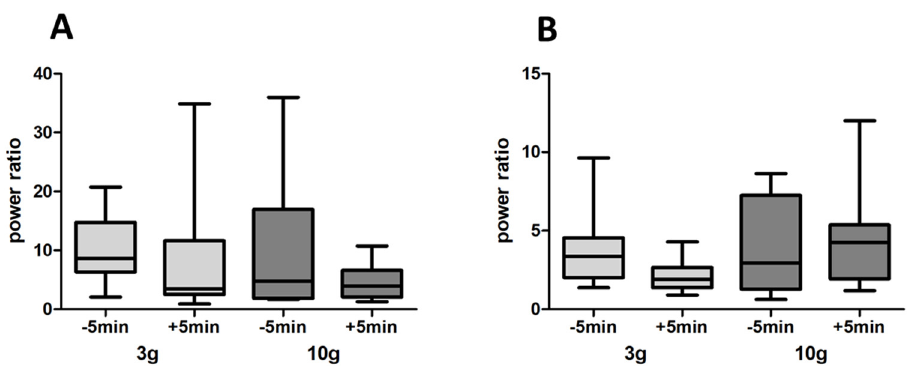
Figure 9. ( A ) . Simultaneous i.v. administration of the D1 agonist A68930 and the D2 antagonist ra- clopride had no effect on the LFP power increase elicited by 3 g and 10 g food odour. Olfactory stimulations were performed 5 min before and 5 min after injection ( n = 8 rats). ( B ). Simultaneous i.v. administration of the D1 antagonist SCH23390 and the D2 agonist quinpirole had no effect on LFP power increase elicited by 3 g and 10 g food odour. Olfactory stimulations were performed 5